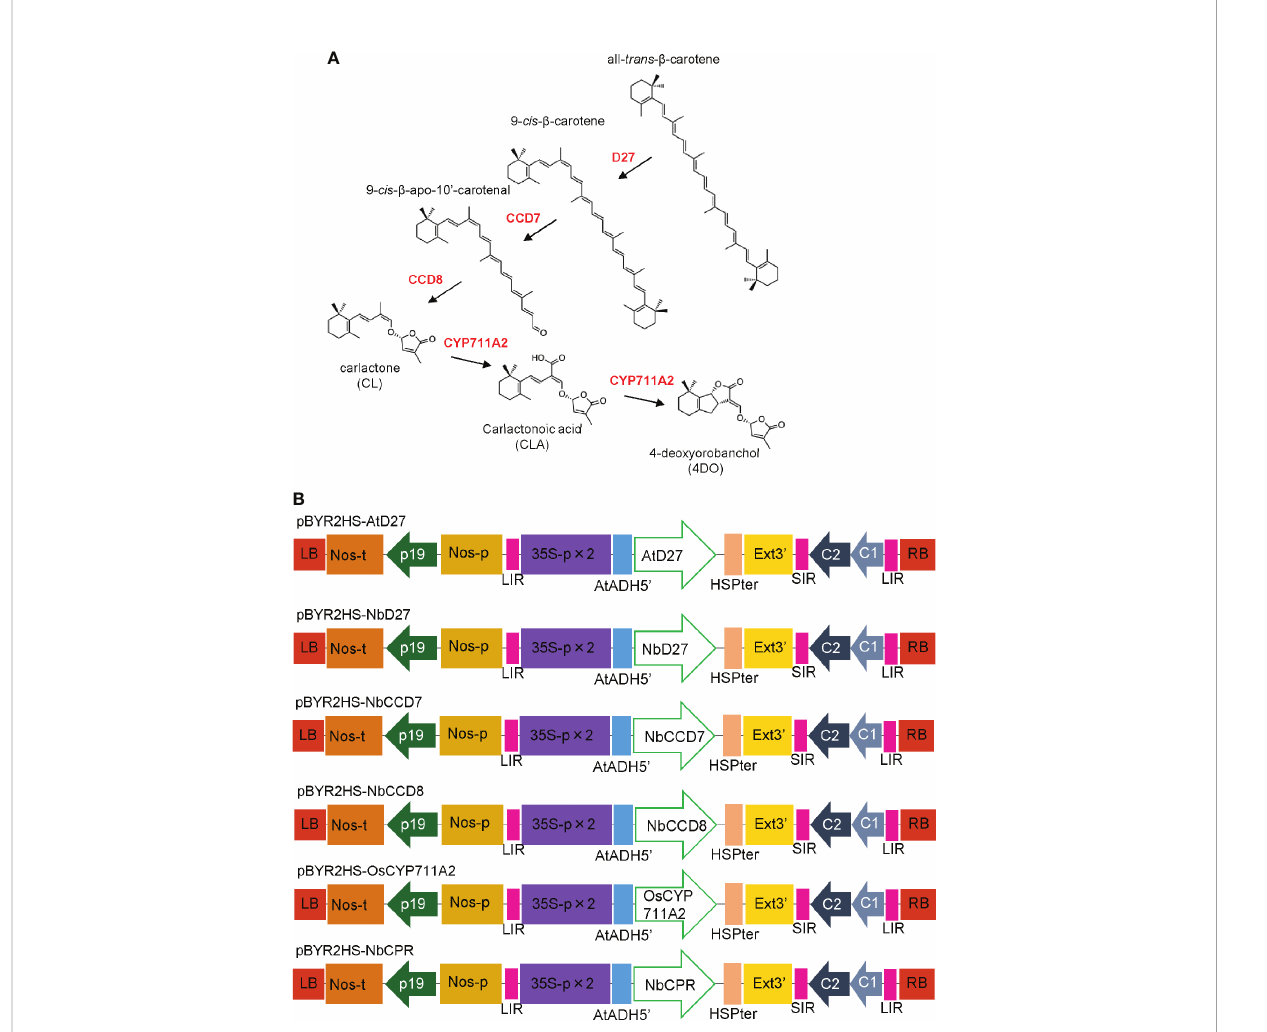
FIGURE 1 (A) Mechanism of biosynthesis of 4-deoxyorobanchol (4DO) from b -Carotene. b -carotene is converted into carlactone (CL) by D27, CCD7, and CCD8. OsCYP711A2 catalyzes the conversion of CL to 4DO in rice. (B) Schematic representation of the T-DNA regions of the plasmids, pBYR2HS-AtD27, pBYR2HS-NbD27, pBYR2HS-NbCCD7, pBYR2HS-NbCCD8, pBYR2HS-OsCYP711A2, or pBYR2HS-NbCPR. 35S-p x 2, CaMV 35S promoter with the double-enhanced element; AtADH5 ’ , 5 ’ -untranslated region (UTR) of Arabidopsis thaliana alcohol dehydrogenase gene; HSPter, heat shock protein gene terminator; Ext3 ’ , tobacco extensin gene 3 ’ element; LIR, long intergenic region of the bean yellow dwarf virus (BeYDV) genome; SIR, short intergenic region of the BeYDV genome; C1/C2, BeYDV ORFs C1, and C2 encoding replication initiation protein (Rep) and RepA, respectively; LB and RB, left and right borders of the T-DNA region, respectively; Nos-p and Nos-t, NOS promoter and terminator, respectively; p19, a gene-silencing suppressor gene from the tomato bushy stunt